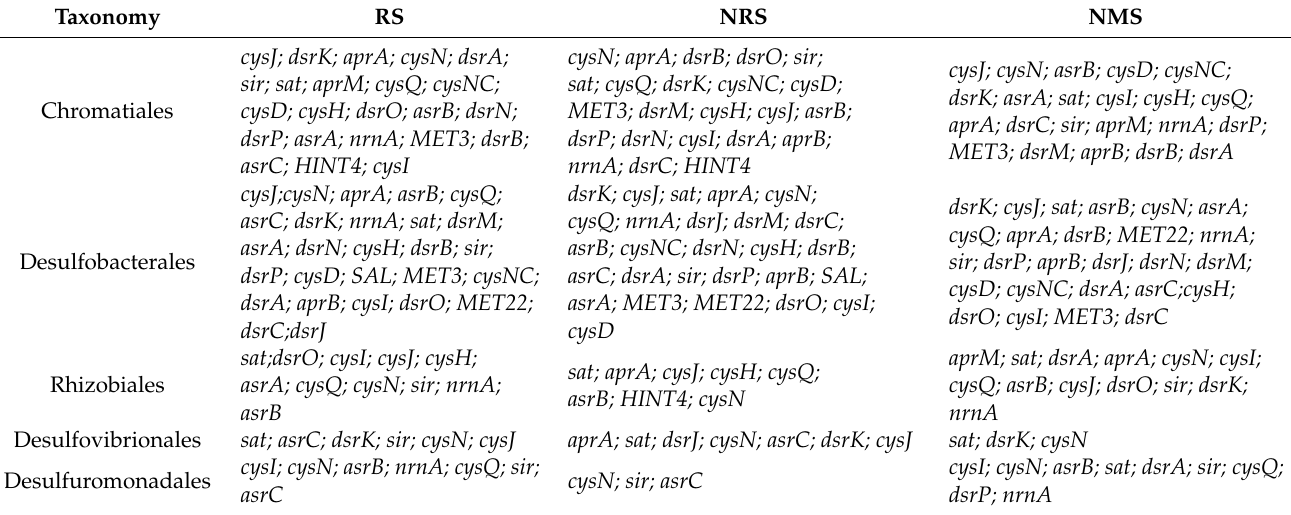
Table 1. Taxonomic assignments of dissimilatory sulfate-reduction